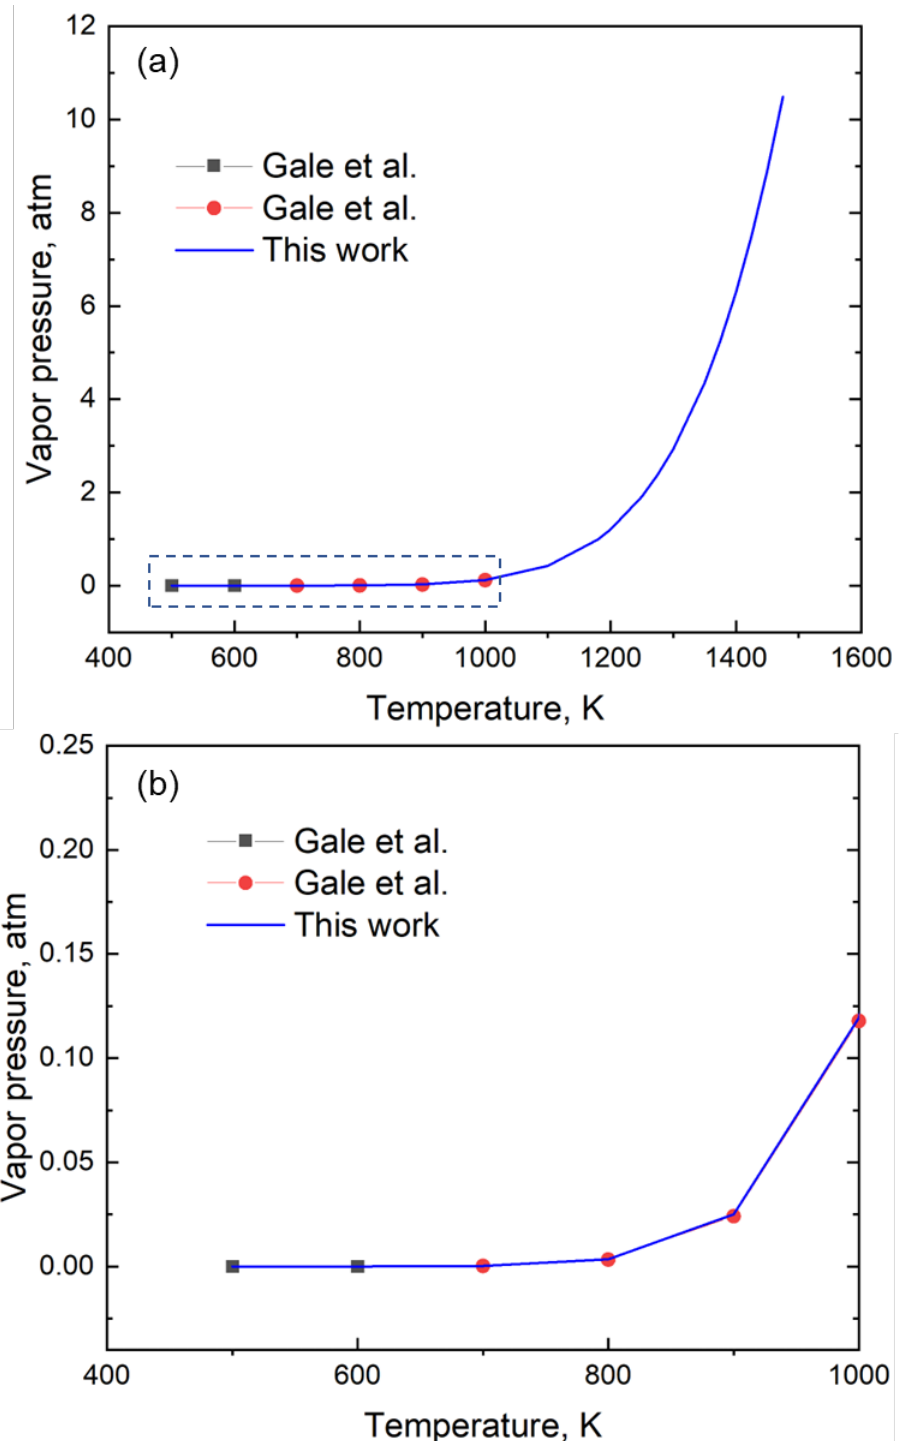
Figure 4. ( a ) A plot of the vapor pressure data of Zn using data from the handbook and the coefficients generated in this study. While Gale et al. [14] provides two different relations denoted by the black squares (between the temperature of 473 K to 692.5 K) and red circles (temperature of 692. K to 1000 K), our work represents the variation in vapor pressure data using a single relation. ( b ) The enlarged section of the low-temperature vapor pressure data between 400 K and 1000 K shows a good fit with the